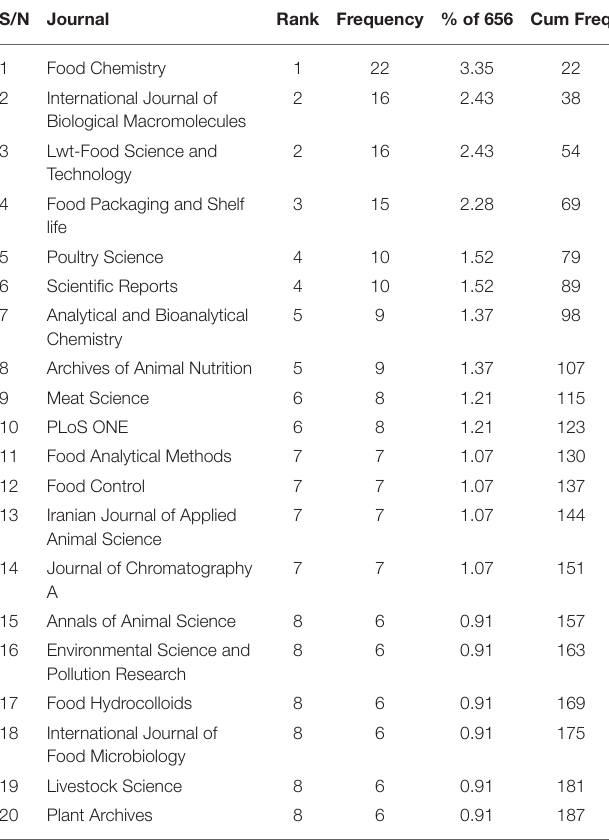
TABLE 7 | The top 20 articles that are relevant in the field of meat production and nanotechnology from 1985 to